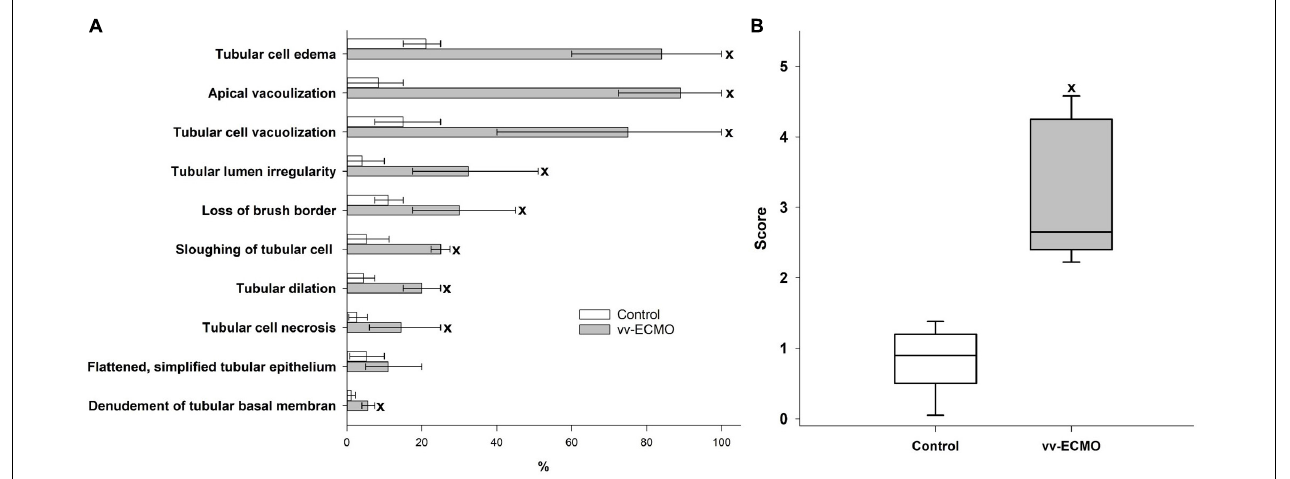
FIGURE 4 | The extent of the renal histological changes (A) in the control group (empty column) and vv-ECMO group (gray column). The plots demonstrate the median (top line of the column) and the 25th and 75th percentiles (whiskers). x P < 0.05 for the vv-ECMO vs. control group values (Mann–Whitney test). Changes in the renal histology score (B) in the control group (empty box) and vv-ECMO group (gray box). The plots demonstrate the median (horizontal line in the box), the 25th and 75th percentiles, and the range of data (whiskers). x P < 0.05 for the vv-ECMO vs. control group values (Mann–Whitney test).